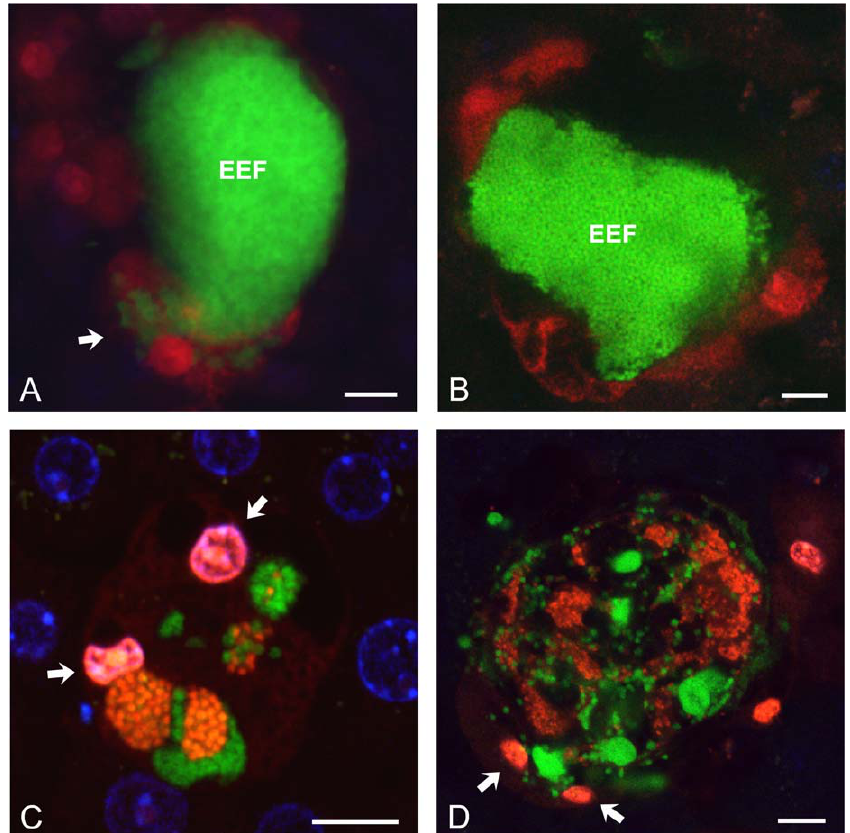
Figure 4. Hepatocyte and Merozoite Viability during Merosome Formation At 52–70 h after infection with PyGFP, mice were intravenously injected with a mixture of the membrane-permeable DNA stain Hoechst 33342 and the dead cell dye PI prior to intravital microscopic examination. (A) Confocal scan showing an intact EEF that has not incorporated PI (red) and is therefore considered viable. Note that merozoites have been discharged into surrounding cells (arrow) some of which have taken up the red dead cell stain. (B) Due to merosome formation, this EEF has decreased in size and detached from the surrounding tissue. The neighboring cells appear to be compressed and are stained with PI (red). (C) A few merozoites are left behind in an EEF that has disintegrated after repeated merosome budding. The two nuclei of the host cell (arrows) have incorporated predominantly PI (red) and some Hoechst stain (blue) and appear pink. In addition, some of the merozoites have lost their green fluorescence and appear red due to PI staining, while others have retained GFP and excluded PI and are therefore viable. The nuclei of the neighboring hepatocytes are visualized by Hoechst staining (blue). (D) EEF at a late stage of disintegration. Some remaining merozoites are viable (green), while other merozoites are dead (red). The nuclei of some surrounding cells have also incorporated PI (arrows). Bars ¼ 10 l m.